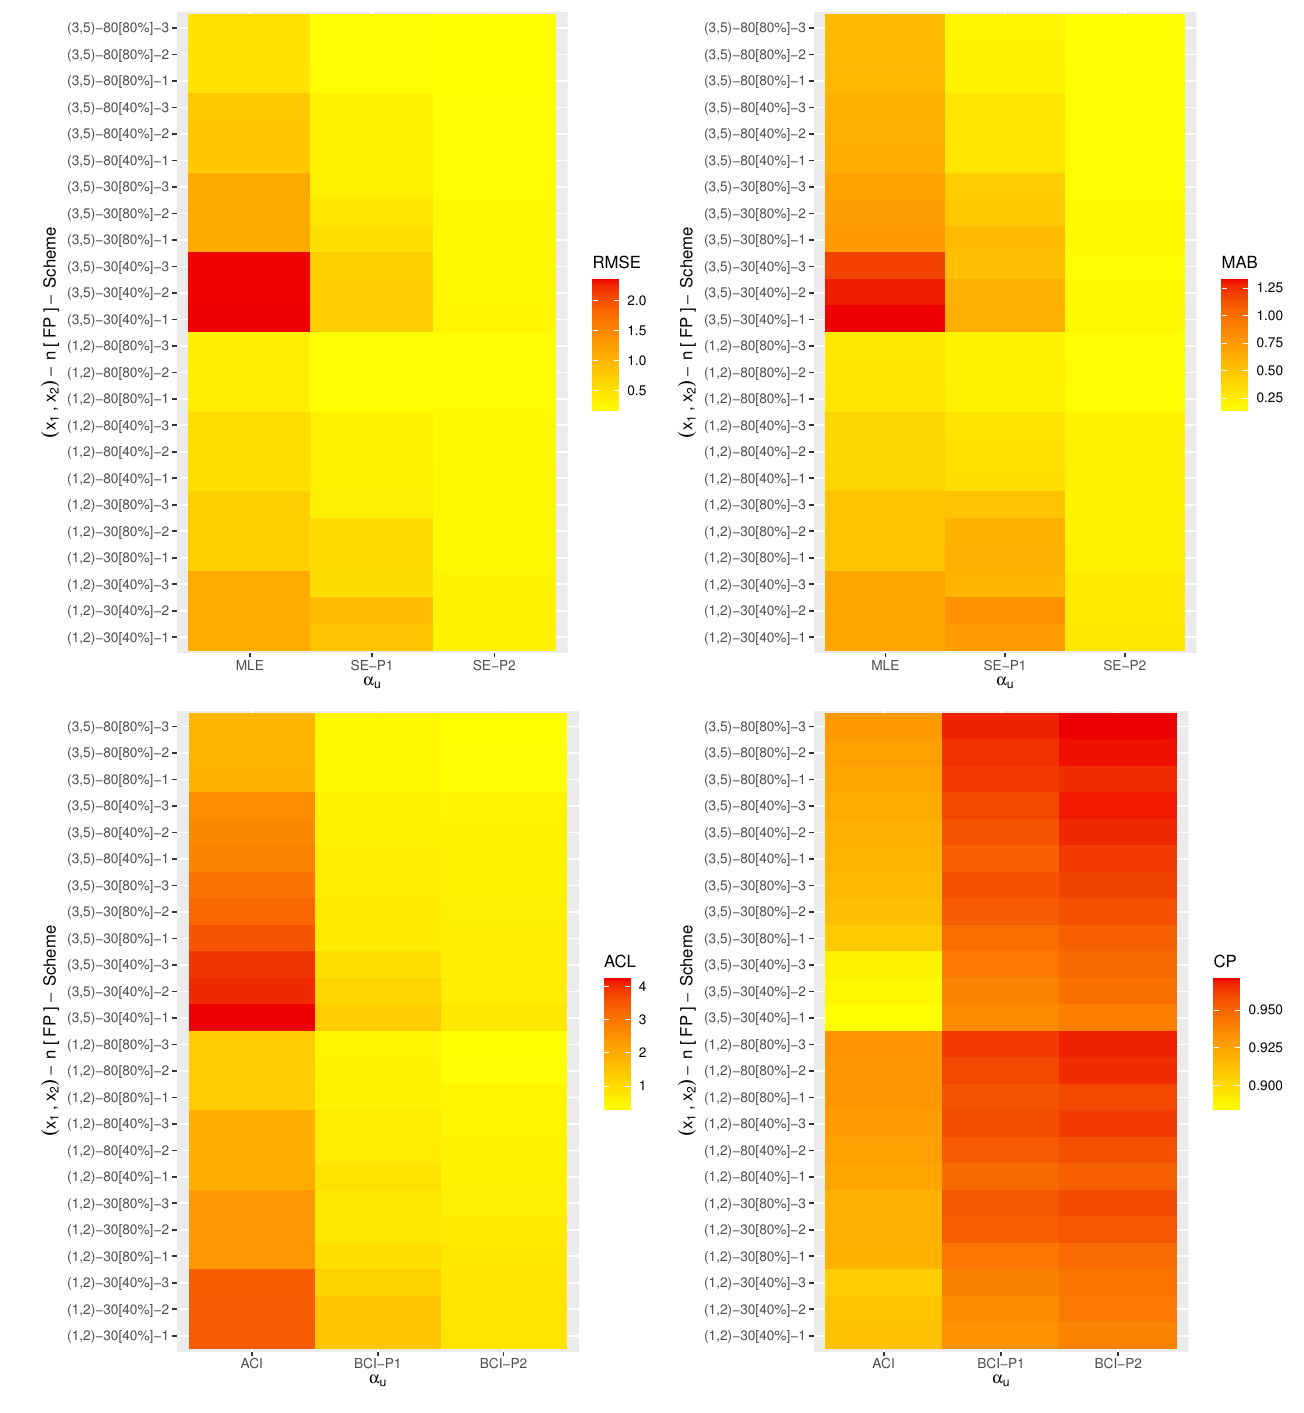
Figure 4. Heat map for the simulation results of α u